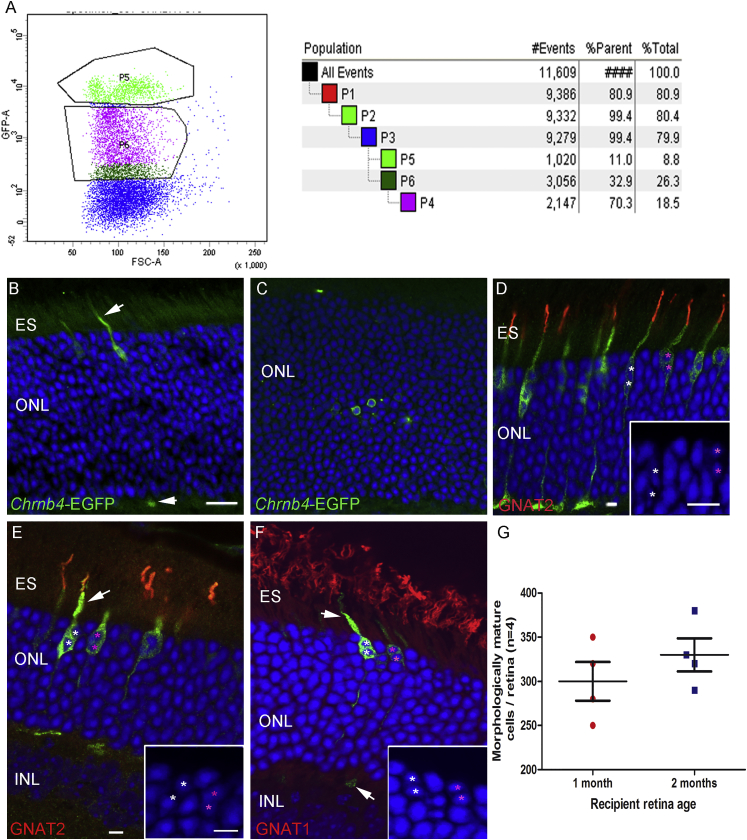
Presumptive Cone Precursors and Newborn Cones from E15.5 Chrnb4-EGFP Retinas Generate the Appearance of EGFP-Positive Mature Cones after Transplantation into Adult NOD/SCID Retinas(A) Flow cytometry analysis of Chrnb4-EGFP-positive cell populations from dissociated E15.5 mouse retinas. Only the cells presenting the highest EGFP expression (P5 gated cells, in green) were transplanted. (B and C) Examples show (B) mature and (C) immature cone photoreceptors detected in adult recipient retinas. Note the presence of outer segments (white arrow, B). (D) Example is shown of a 2-month-old Chrnb4-EGFP-positive mouse retina stained for GNAT2 as control staining. Mature GNAT2-positive (E) and GNAT1-negative cones (F) 4 weeks after transplantation into NOD/SCID mice are shown. (B, E, and F) White arrows indicate external segment or synapsis. (G) Quantification is shown of morphologically mature cells observed in the adult retinas defined by the presence of the external segment or synapsis-like morphology. DAPI, nuclear staining (blue); ONL and INL, outer and inner nuclear layer; ES, external segment; n = 4 per experiment. (D) No significant variations of cell integration were revealed with two different ages of mouse recipients, n = 3. Error bars correspond to SEM. Scale bars, 20 μm (B and C) and 5 μm (D–F insets).